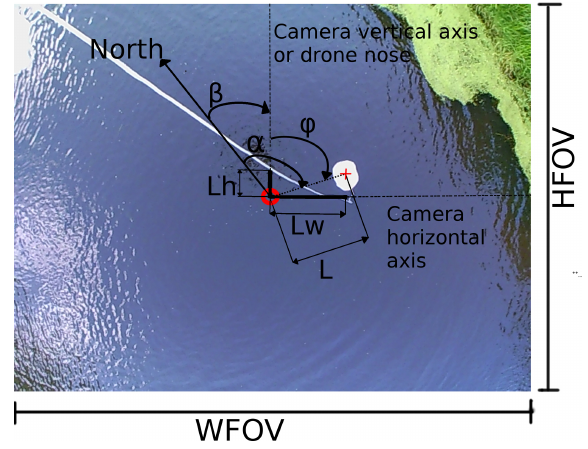
Figure 5. UAV-borne picture of the tethered sonar. WFOV and HFOV are the width and height of the field of view. The tethered sonar is located below the white polyester board floating on the wa- ter surface. The red circle indicates the center of the image, while the red cross indicates the exact position of the sonar. The north di- rection is retrieved by the IMU. The vertical axis of each image cap- tured by the camera coincides with the drone heading. β is the angle between the drone heading and the north. ϕ is the angle measured clockwise from the camera vertical axis to the vector ( L ), which is the vector on the horizontal plane connecting the sonar to the image center. Lh and Lw are the vertical and horizontal components of the vector L . α is the azimuth angle measured clockwise from the north direction to L . Angles and vectors highlighted in this figure are on the horizontal plane, i.e., on the water